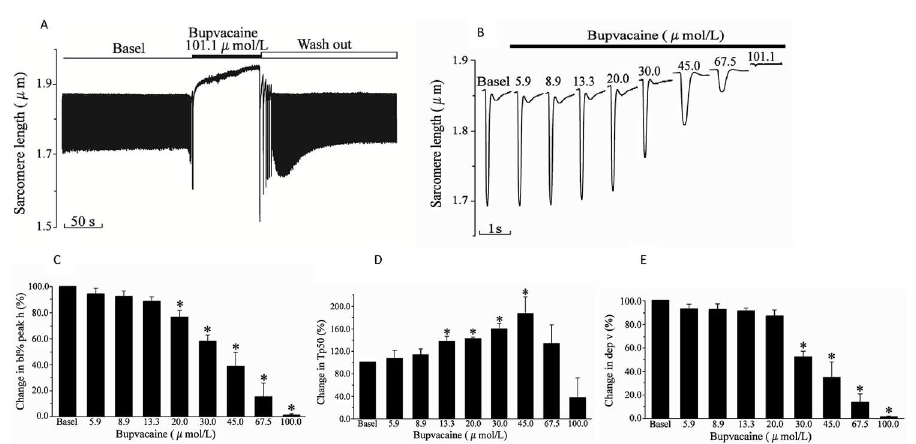
Fig 3. Bupivacaine mediated a concentration-dependent depression on contraction of rat cardiomyocytes. (A) Representative sarcomere-shortening trace before and after exposure to bupivacaine. Y axis: changing of sarcomere length recorded during myocyte contraction; X axis: perfusates. (B) Representative individual signal of cardiomyocyte sarcomere contraction in the presence of bupivacaine at different concentrations. (C), (D), and (E) Statistical analysis of effect of bupivacaine on bl% peak h, Tp50 and dep v. Data are the mean ± SD. (cid:3) P < 0.05, vs . basal amplitude.